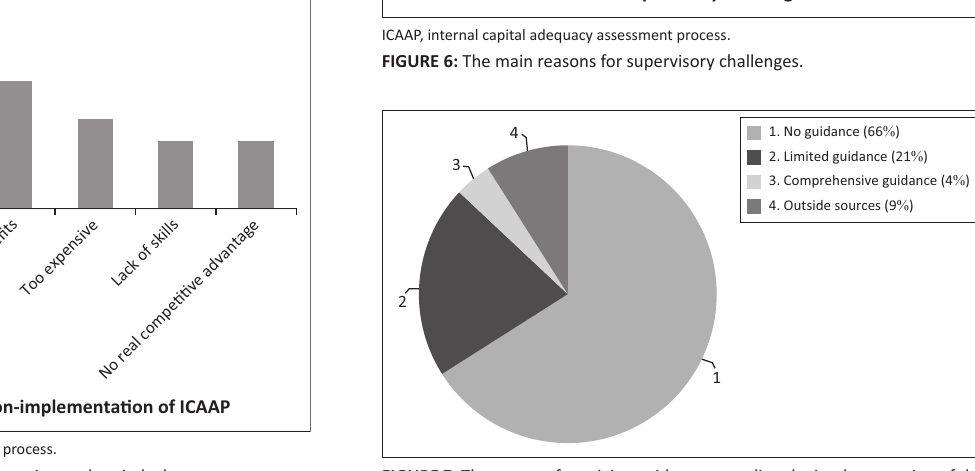
FIGURE 7: The extent of receiving guidance regarding the implementation of the internal capital adequacy assessment process.